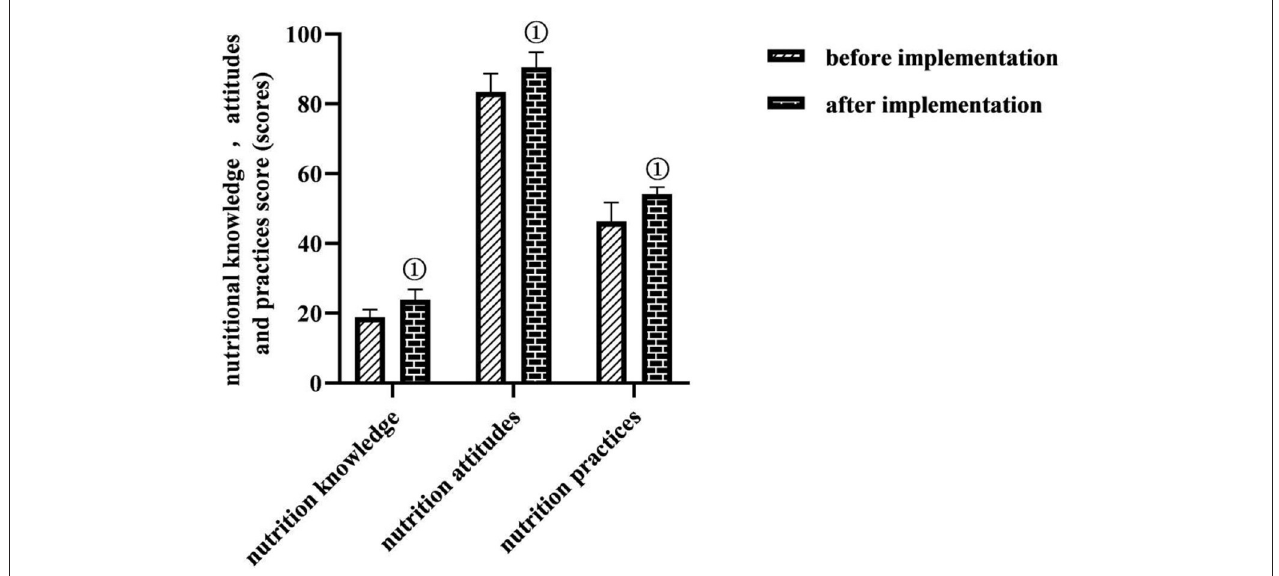
FIGURE 5 | Comparison of nutrition knowledge, attitude, and practice scores of caregivers in the study group before and after care implementation ( M ± SD , scores). ‹ P < Comparison with the same dimension before implementation,